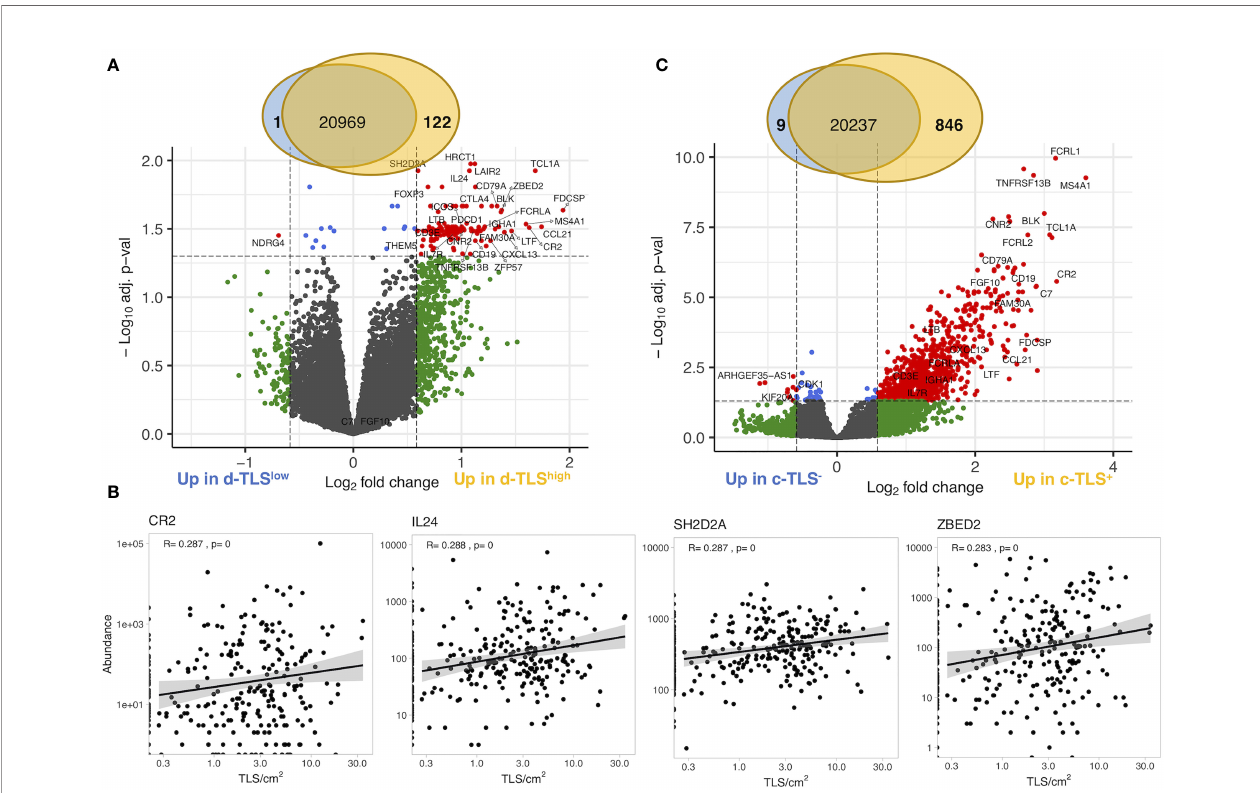
FIGURE 2 | Gene expression in intratumoral regions poorly correlates with d-TLS density. (A) Gene expression measured by bulk tumor RNA sequencing of intratumoral regions (cryosamples) was compared in d-TLS density groups by two-tailed t -test with Benjamini – Hochberg adjustment for multiple testing. Differentially expressed genes were de fi ned as genes with expression change of 50% (log2 fold change of 0.585) and adjusted p -value <0.05 (log10 adj. p -value <-1.3) and are displayed as red dots in the Volcano plot. (B) Spearman correlation analysis was done to establish the direct relationship between intratumoral DEG abundance and d-TLS density. Representative plots of the most signi fi cant correlations are shown. (C) Gene expression was compared in patient groups de fi ned by the presence or absence of TLS in their cryosamples (c-TLS) by two-tailed t -test and Benjamini – Hochberg adjustment for multiple testing. Signi fi cant DEGs were de fi ned and visualized as in (A)